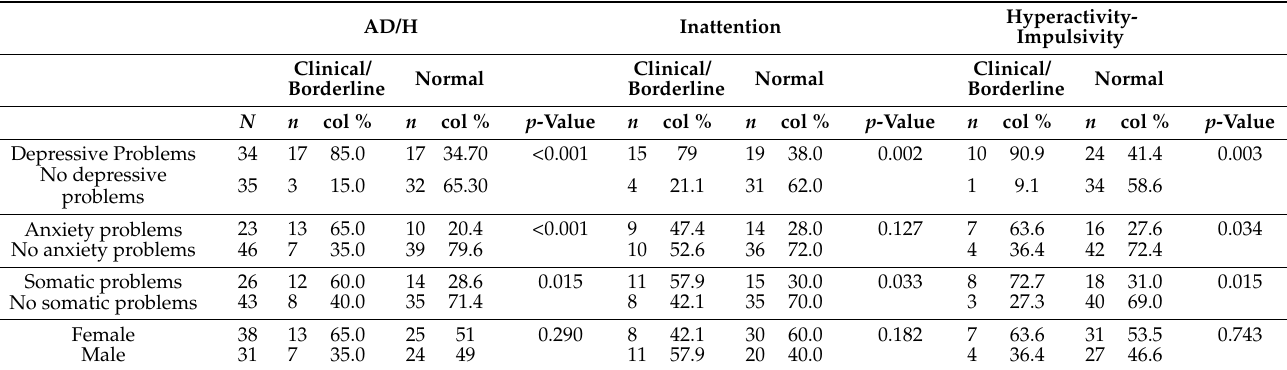
Table 3. Association between the comorbid symptoms and symptoms of AD/H, AD, and H-I in adults with FD when using the ASEBA Adult Self-Report.